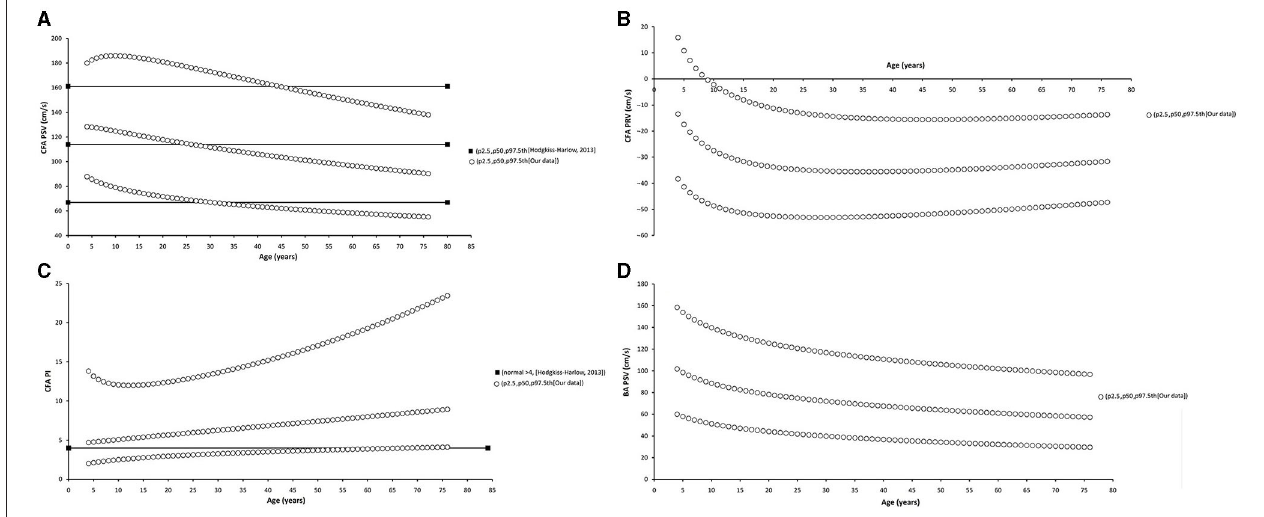
FIGURE 12 | Common femoral artery (CFA) and brachial artery (BA). Comparison between curves of CFA PSV (A) , CF PRV (B) , CFA PI (C) , and BA PSV (D) obtained in our study (2.5th, 50th, and p97.5th percentiles) and mean values (p50th), and 2.5th (MV − 1.96 × SD) and 97.5 (MV + 1.96 × SD) percentiles obtained by other authors when studying groups of adults. The fixed cut-off levels used to identify (graduate) levels of arterial stenosis are also